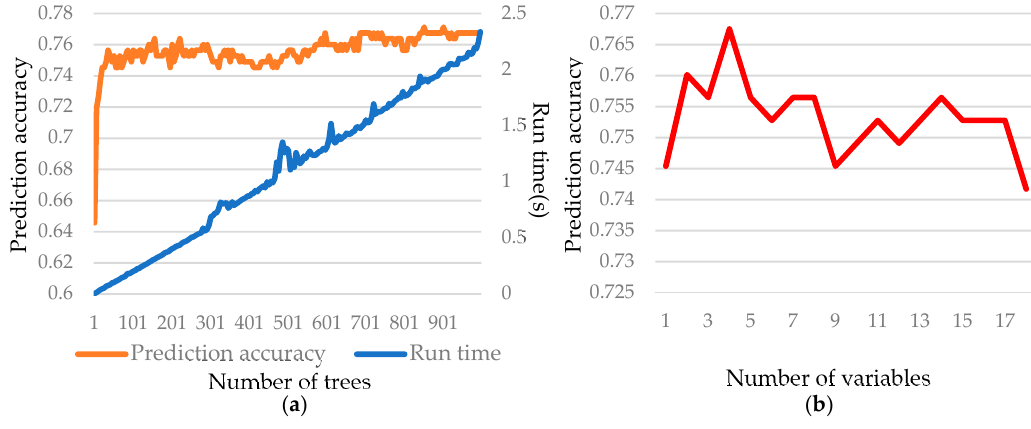
Figure 10. The performance under the change of parameter; ( a ) represents the change in number of trees; ( b ) represents the variety of quantity of variables.